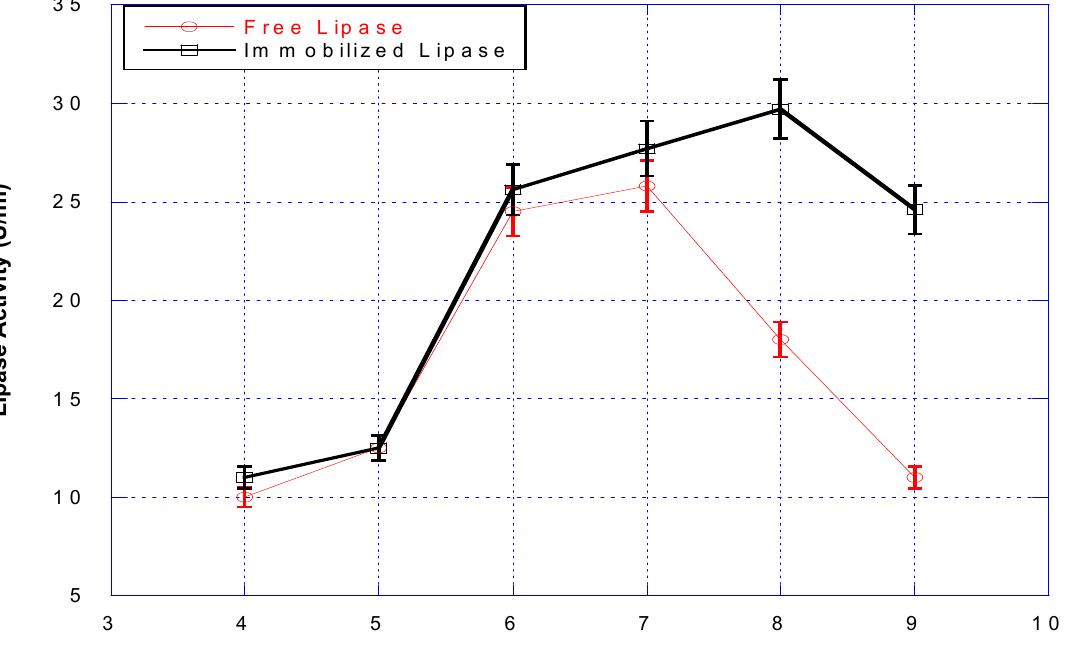
Figure 2. Effect of pH on the activity of free ( red line ) and immobilized ( black line ) lipases.